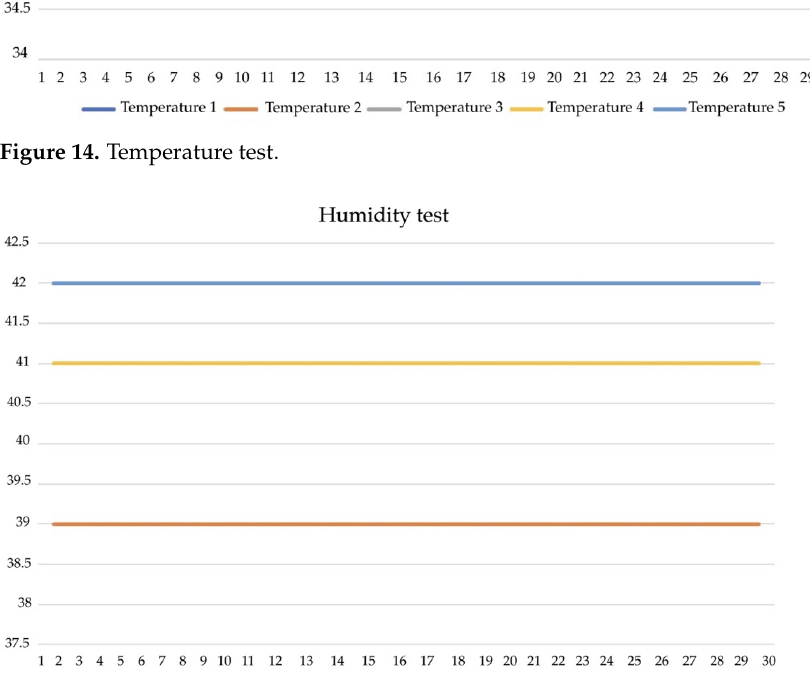
Figure 15. Humidity test.